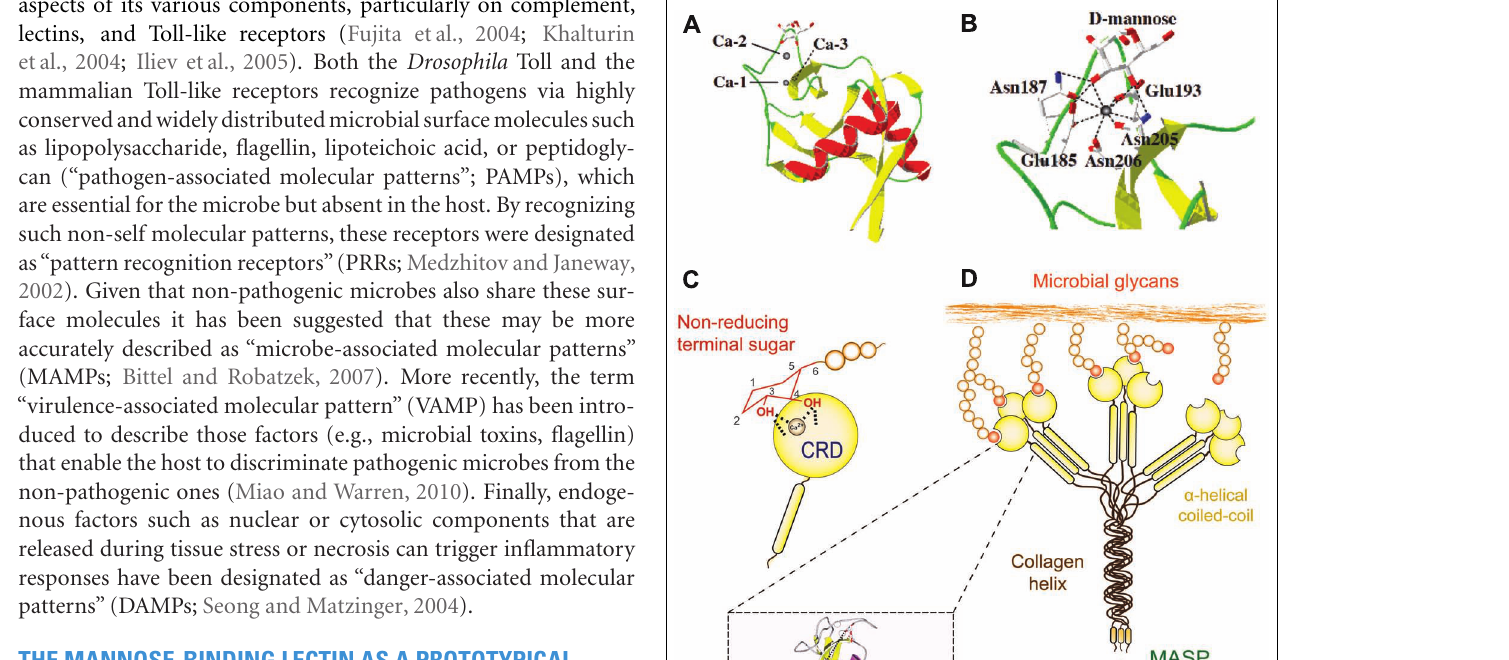
disulfide bridges at the bases of the loops. The residues C1 and C4 link β 5 and α 1 (the whole domain loop), while C2 and